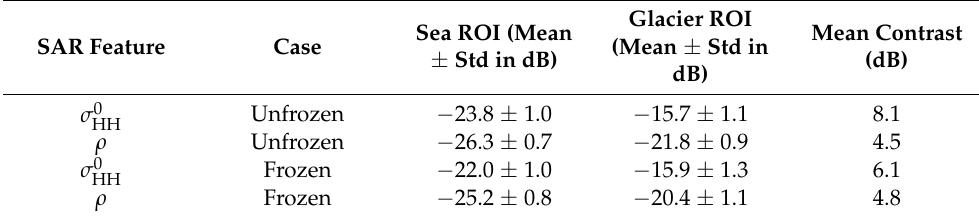
Figure 3. Selected scenes relevant to frozen ( a – c ) and ice-free ( d – f ) sea surfaces. Panels ( a , d ) show the reference Sentinel-2 MSI true-colour optical images; ( b , e ) show the graytone σ 0 dB scale; ( c , f ) show the false-colour ρ images depicted at the dB scale. In panels ( a , d ), cyan and white squares indicate the sea and glacier ROIs, respectively, which are randomly excerpted for quantitative scattering analysis (see Table 2). The four transects randomly selected for quantitative scattering analysis are also indicated by red dashed lines, where the first and last pixels of the transect are labelled “1” and “100”, respectively, and marked in yellow. Table 2. Mean and standard deviation values of the considered features evaluated for the selected ROIs shown in Figure